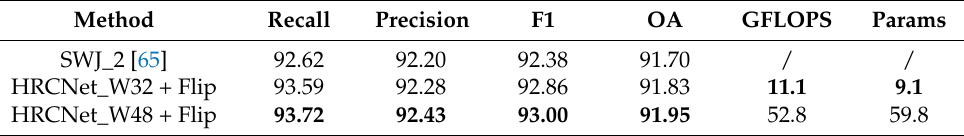
Table 5. Results evaluated by Recall (%), Precision (%), F1 (%), OA (%), GFLOPS (G) and Params (M) on the Potsdam dataset with no boundary.